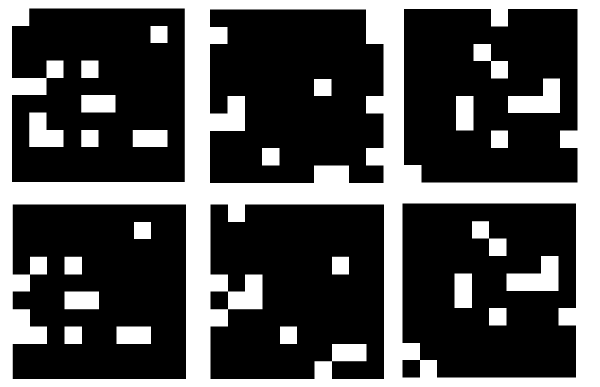
Figure 7. Samples of shifted binary